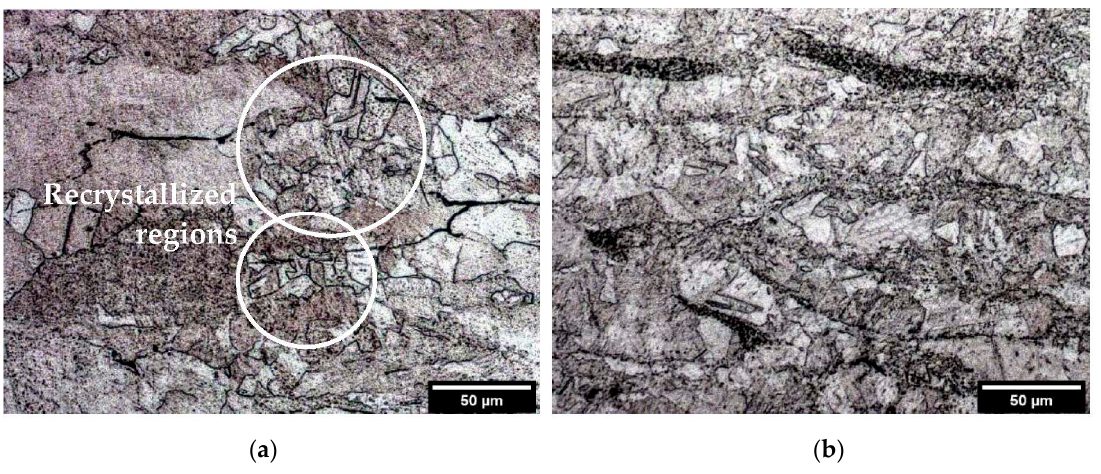
Figure 13. SEM picture of ( a ) sample IP deformed at 800 °C–0.1 s − 1 and ( b ) sample MM deformed at 800 °C–0.1 s − 1 .